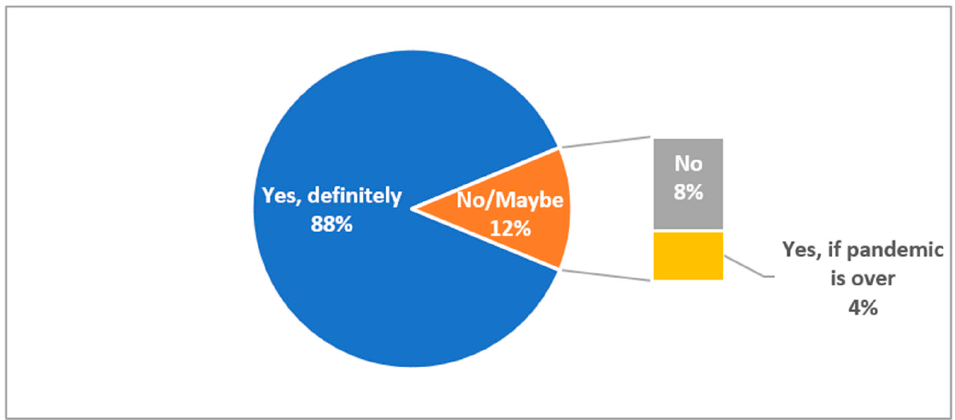
Figure 6. COVID-19 impact on current employment by demographic attribute.